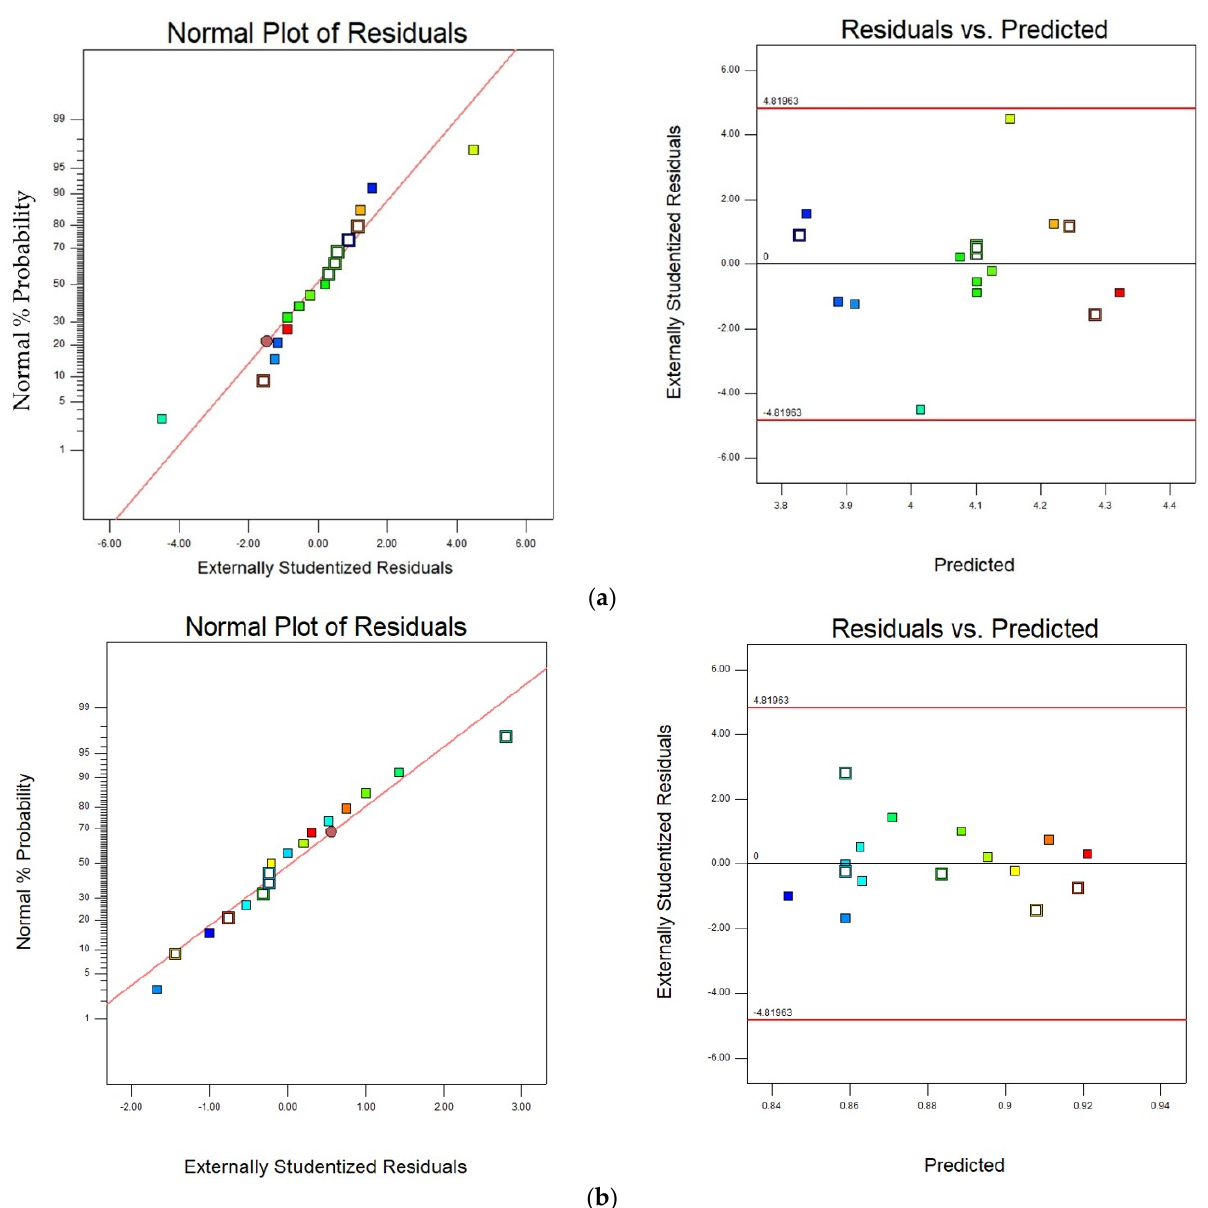
Figure 11. Standard residual error of the regression models. ( a ) Standard residual verification of the threshing loss rate; ( b ) Standard residual verification of the grain breakage rate.